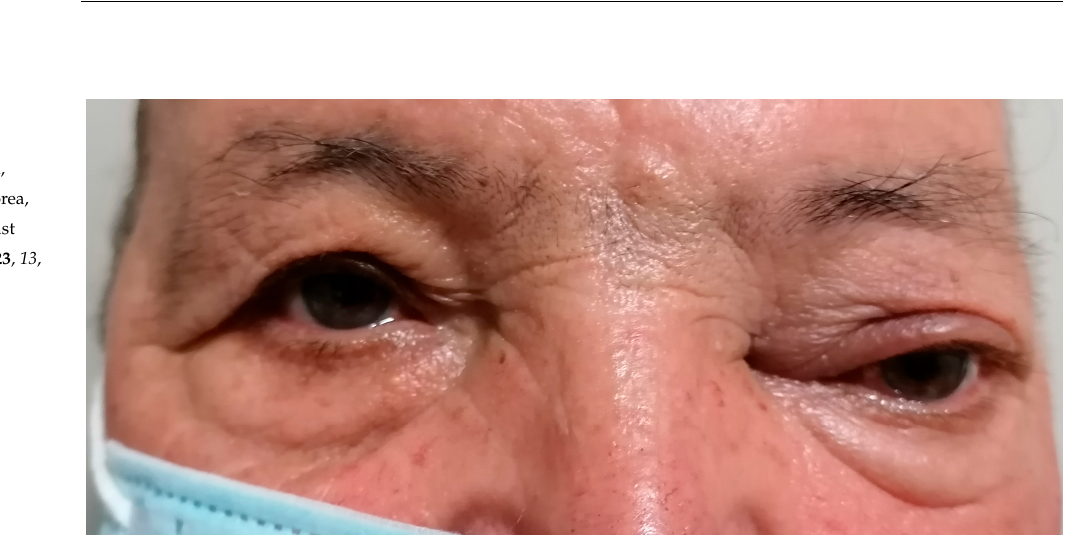
Figure 1. A 65-year-old male presented with blurred vision, diplopia, ocular pain, and a slight swell- ing of the upper eyelid on the left eye. His medical history was remarkable for an infiltrating breast carcinoma (one year ago) for which he had a mastectomy. Ophthalmic examination showed exoph- thalmos on LE with eyeball deviation downwards and outwards with proptosis. The best-corrected acuity vision (BCVA) was 1 for the right eye (RE) and 0.9 for LE. Intra-ocular pressure (IOP) was 19 mmHg for RE and 40 mmHg for LE. The anterior segment for both eyes (OU) was normal. Extra- ocular movement of the left eye was limited in all directions. Examination of the posterior segment under dilatation on LE showed optic atrophy with the pallor of the optic nerve head, and a foveal reflex faded. The posterior segment of RE was normal. Breast cancer is one of the most common oncological pathologies diagnosed in women, being the second cause of death after lung cancer [1].